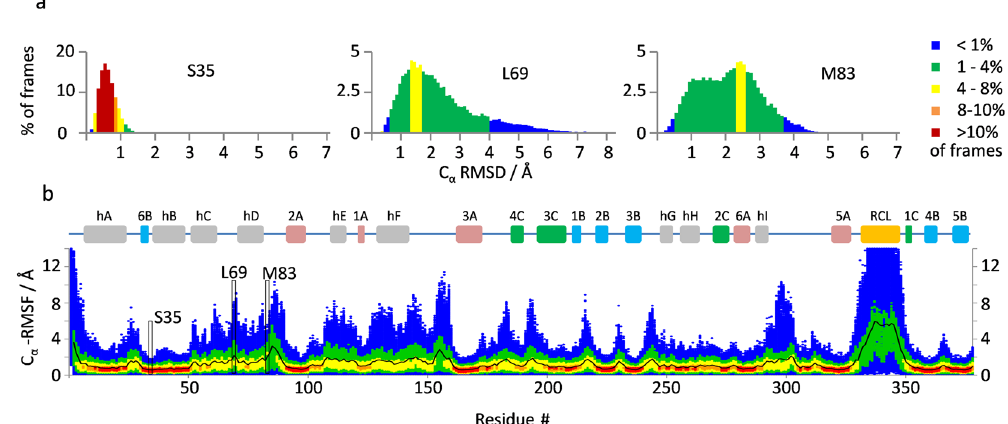
Figure 5. Low frequency – large amplitude motions in active PAI-1. The per-residue, per-frame C α -RMSD values relative to the average structure was calculated once every 200 ps for the four simulations on active PAI-1 (total of 20000 frames). ( a ) For each residue, the frames used for calculations were grouped in C α -RMSD value bins of 0.1 Å size and the %-fraction of frames in each bin was plotted as histograms according to the indicated color scale. ( b ) Data for S37, L69 and M83 in active PAI-1 are shown as examples. The histograms were then collapsed to a 1-dimensional representation and rotated 90° counter clockwise to facilitate the construction of a density plot of the binned C α -RMSD data as a function of PAI-1 residue number in ( b ). The per-residue average C α -RMSD values are indicated by the black